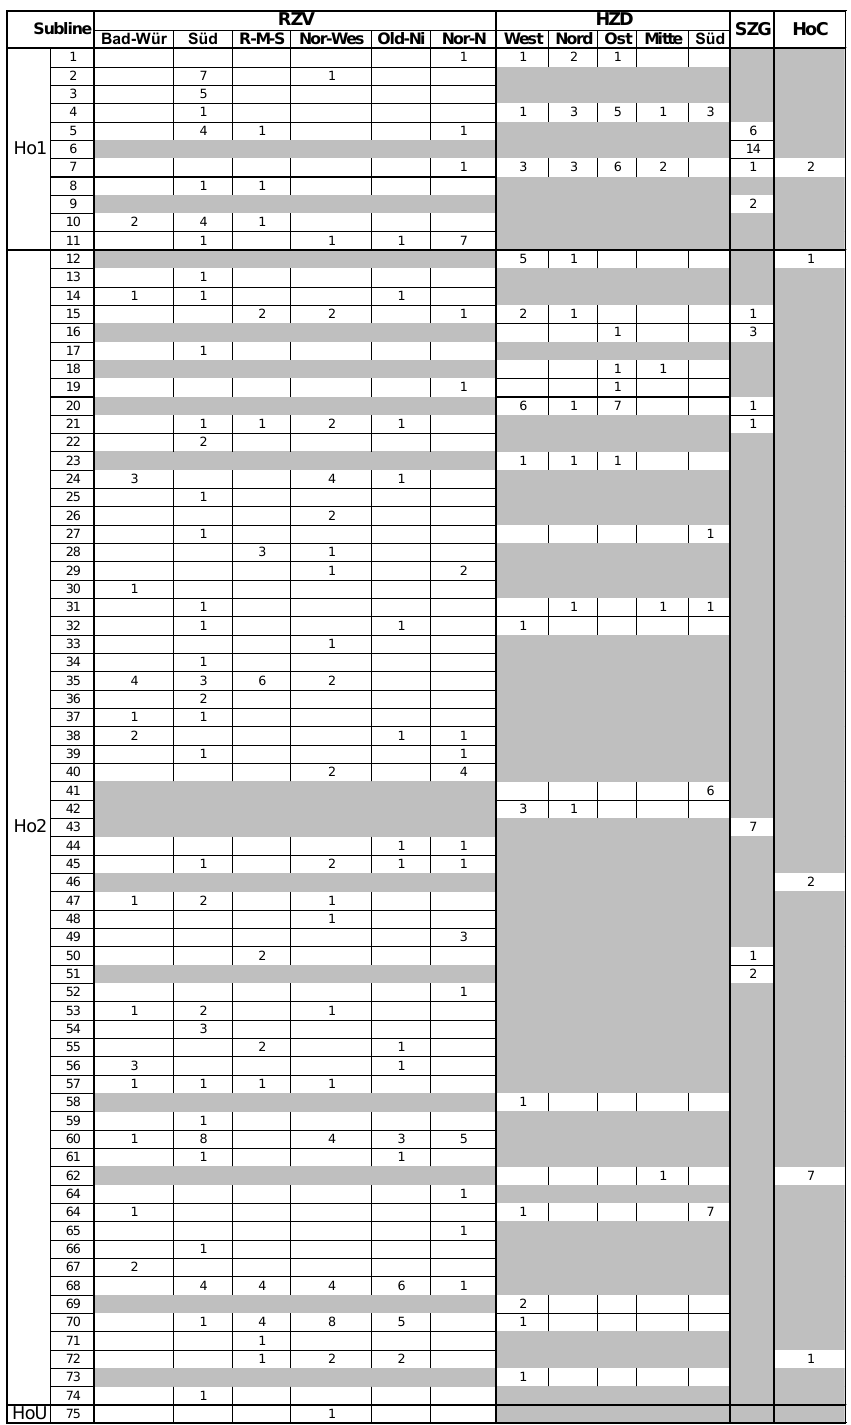
Figure 3. Number of representatives of particular sublines in four kennel organizations: RZV, HZD, SZG and HC, and their branches. Num- bers of the sublines correspond to the numbers in the Fig. 2. Abbreviated names of the RZV branches: Old-Ni – Oldenburg–Niedersachsen; Nor-N – Nord–Nordost; Nor-Wes – Nordrhein–Westfalen; RMS – Rhein–Main–Saar; Bad-Wür – Baden–Württemberg.